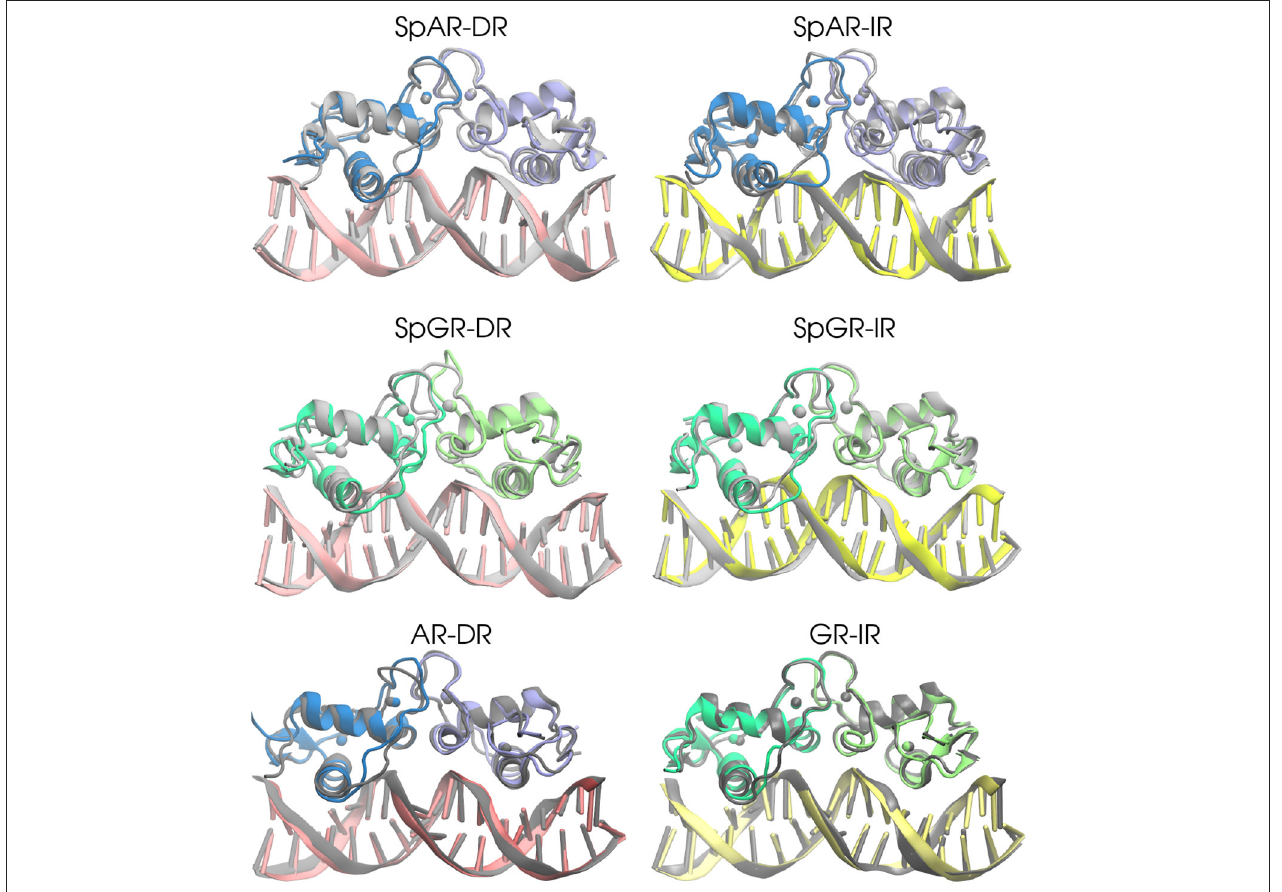
FIGURE 2 | The 3D median structures of the complexes. In each system, the median structure of the last 100 ns of simulation (colored) is aligned to the median structure of the first 100 ns simulation